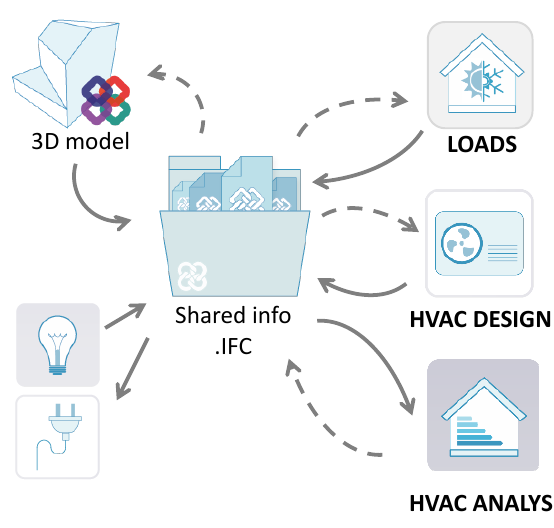
Figure 7. Open BIM workflow.